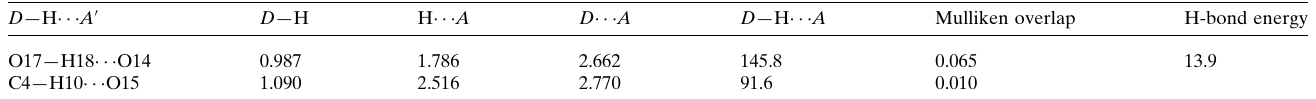
Table 1 Hydrogen-bond geometry (A˚ , (cid:2) , electrons, kcal mol (cid:4) 1 ) for [Li 2 K(C 6 H 5 O 7 )]. D —H (cid:3)(cid:3)(cid:3) A